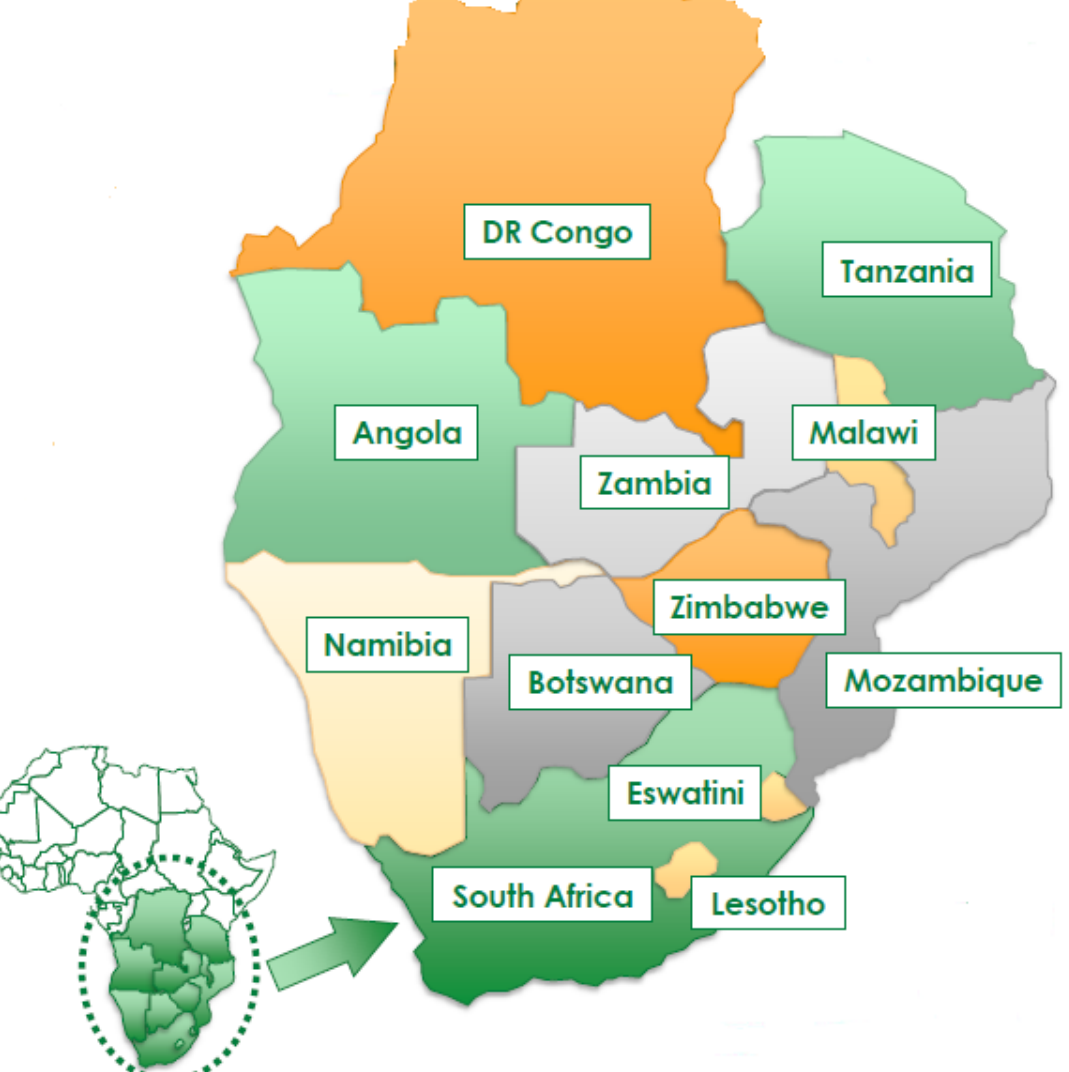
Figure 2. Regional map of Southern Africa.